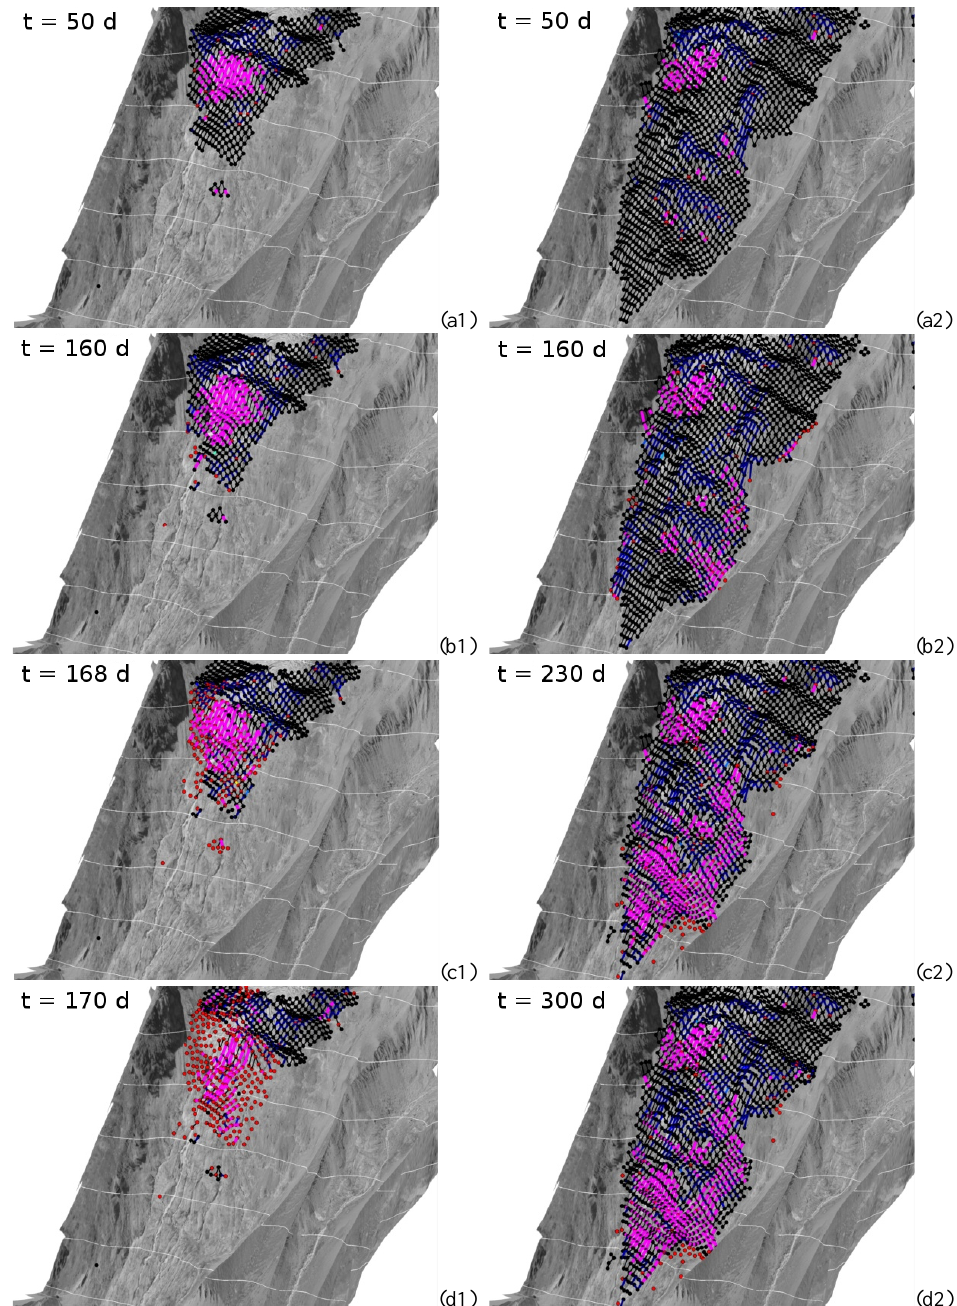
Fig. 13. Snapshots describing the rupture progression and sliding instability in the block lattice for the years 2000 (left) and 1982 (right), with friction coefficients evolving with subglacial flow (see Eq. 1). For the sake of simplicity, blocks are represented as small circles where the black coloured circles indicate static blocks and the red ones the sliding blocks. The colour of a bond evolves from blue to red as the stress changes from larger than s ? (Faillettaz et al., 2010) to close to rupture. Bonds where stress is lower than s ? are drawn in thin black. Bonds in compression are coloured